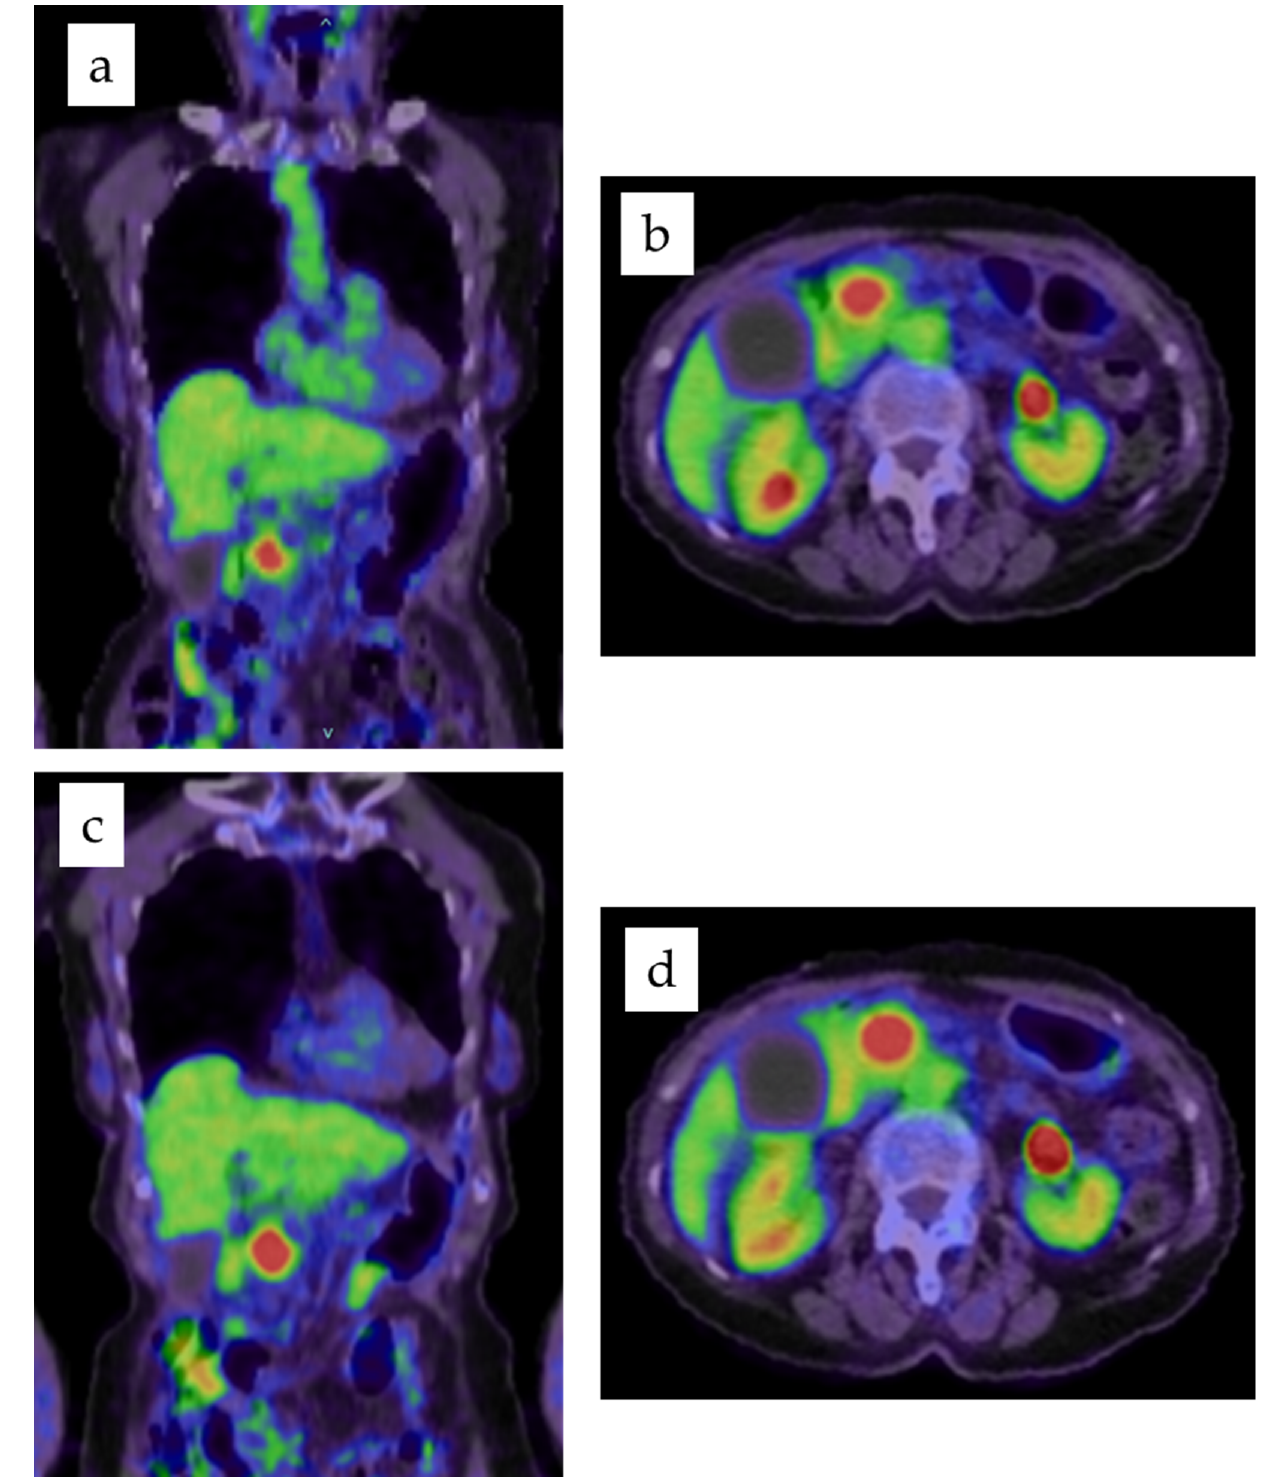
Figure 1. Maximum intensity ( a ) coronal and ( b ) axial images of the first scan in FDG PET/CT, and maximum intensity ( c ) coronal and ( d ) axial images of the second scan in FDG PET/CT. SUVmax1 was 8.9. SUVmax2 was 11.2.